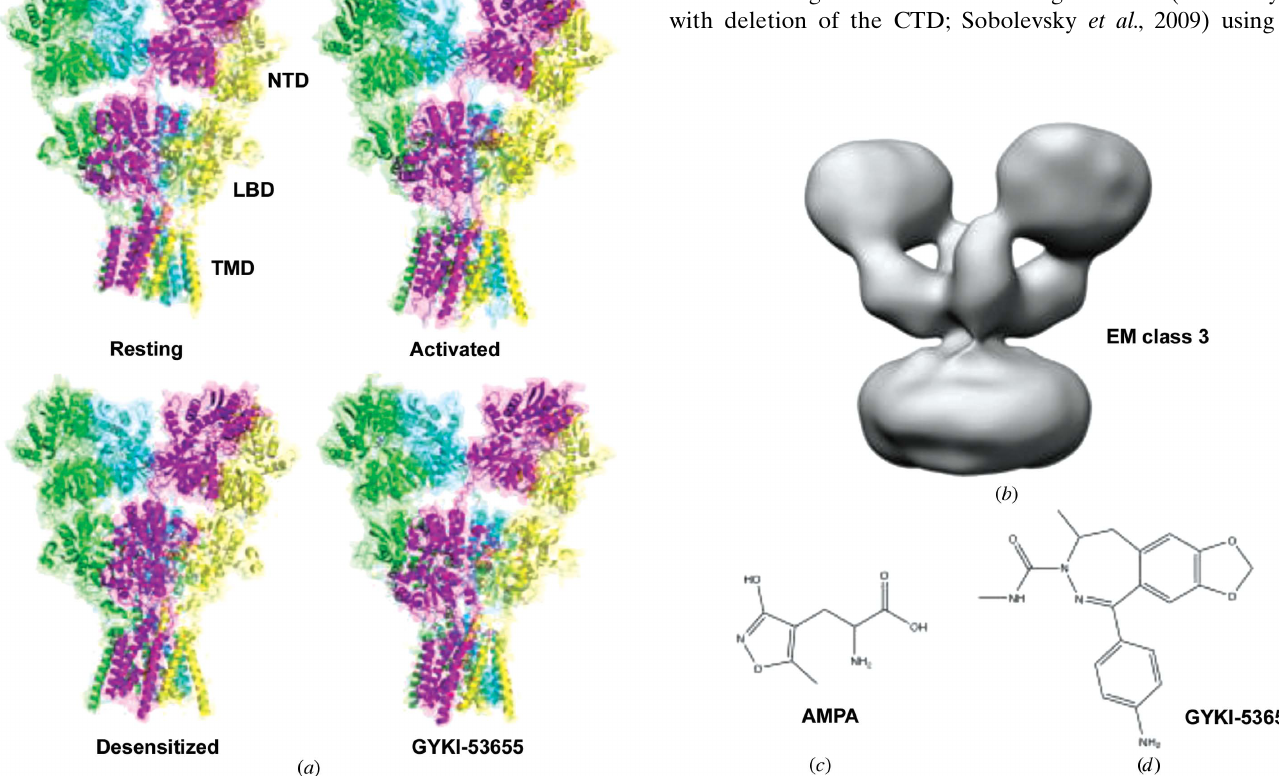
Figure 1 Structures. ( a ) GluA2 in the resting (apo) state (PDB entry 4u2p; Du¨rr et al. , 2014), the activated state (PDB entry 5weo; Twomey et al. , 2017 b ), the desensitized state (PDB entry 5vhz; Twomey et al. , 2017 a ) and with a negative allosteric modulator bound (PDB entry 5l1h; Yelshanskaya et al. , 2016). The N-terminal domain (NTD), ligand-binding domain (LBD) and transmembrane domain (TMD) are indicated in the figure. Parts of the TMD have not been modelled in the structures. ( b ) The EM class 3 structure (EMDataBank EMD-2688; Meyerson et al. , 2014). ( c ) The agonist AMPA. ( d ) The negative allosteric modulator